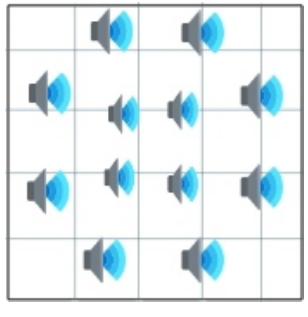
Figure 7. Circular